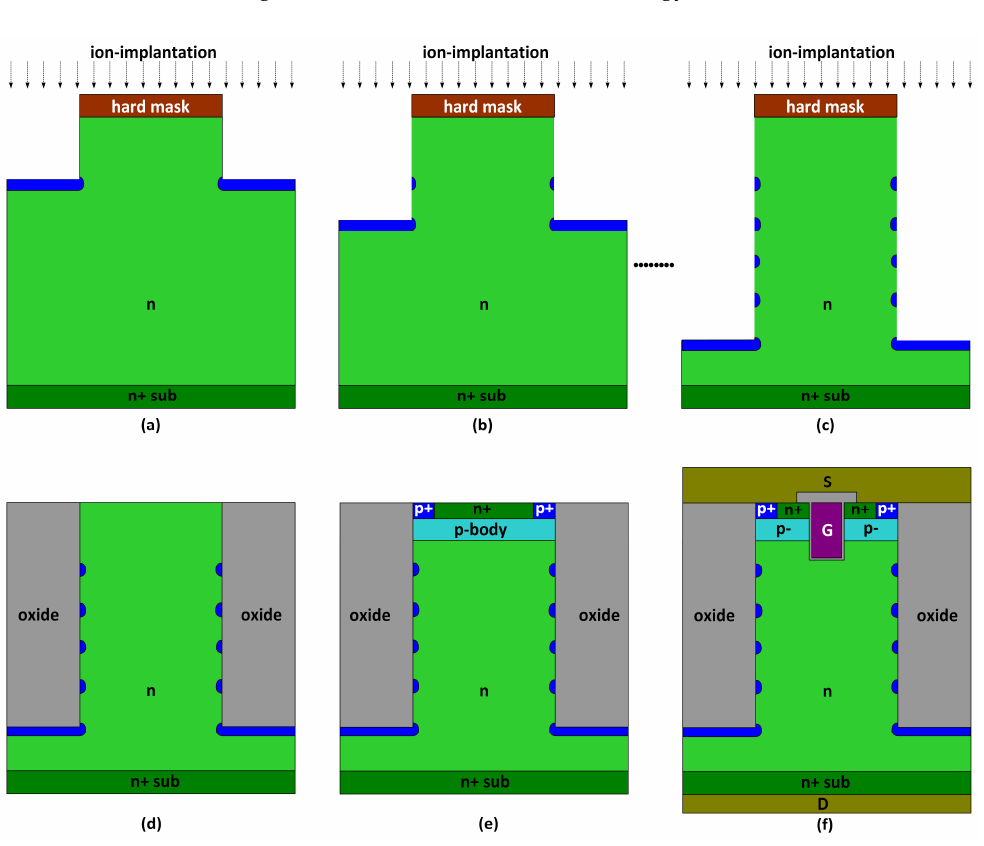
Figure 10. Proposed process flow for the MOSFET featuring trench oxide and p-islands: ( a ) patterned silicon oxide and the topmost p-island formation by etching and ion-implantation; ( b ) second topmost p-island definition in the same manner; ( c ) the other p-islands formation by repeated etching and ion-implantation, and a thermal process to activate the dopants and further enhance the lateral spread of the dopants; ( d ) trench oxide growth and etching back; ( e ) p-body, p + -source, n + -source as well as ( f ) trench gate and contact formation in the same manner as the conventional trench MOSFET.